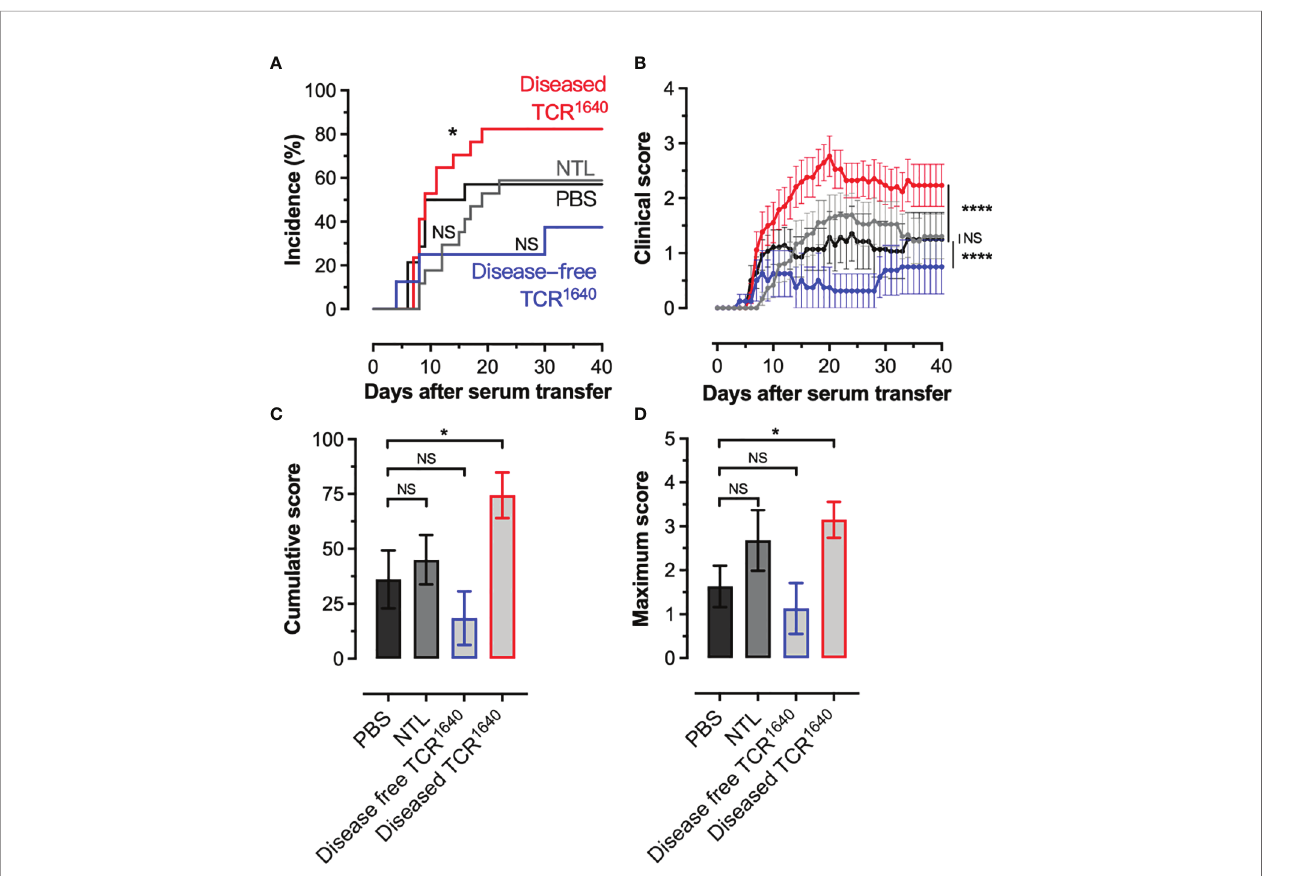
FIGURE 3 | Pathogenicity of MOG-antibodies by serum transfer into EAE prone recipients. (A, B) Mild EAE develops in 2D2 MOG-TCR Tg mice after 2 injections (Days 0, 2) of pertussis toxin (Incidence 50%). These PT treated 2D2 mice received PBS (n=14) or serum from disease-free TCR 1640 mice (n = 8), diseased TCR 1640 mice (n = 17) or NTL mice (n = 18) 2 days after the fi rst PT injection. (A) Incidence of EAE over time. (B) Mean clinical disability ± SEM presented over time (days after serum transfer). Log-rank test (A) , 2-way ANOVA (B) , student t-test (C) , Mann-Whitney U test (D) was used to compare the clinical evolution of EAE. The data was pooled